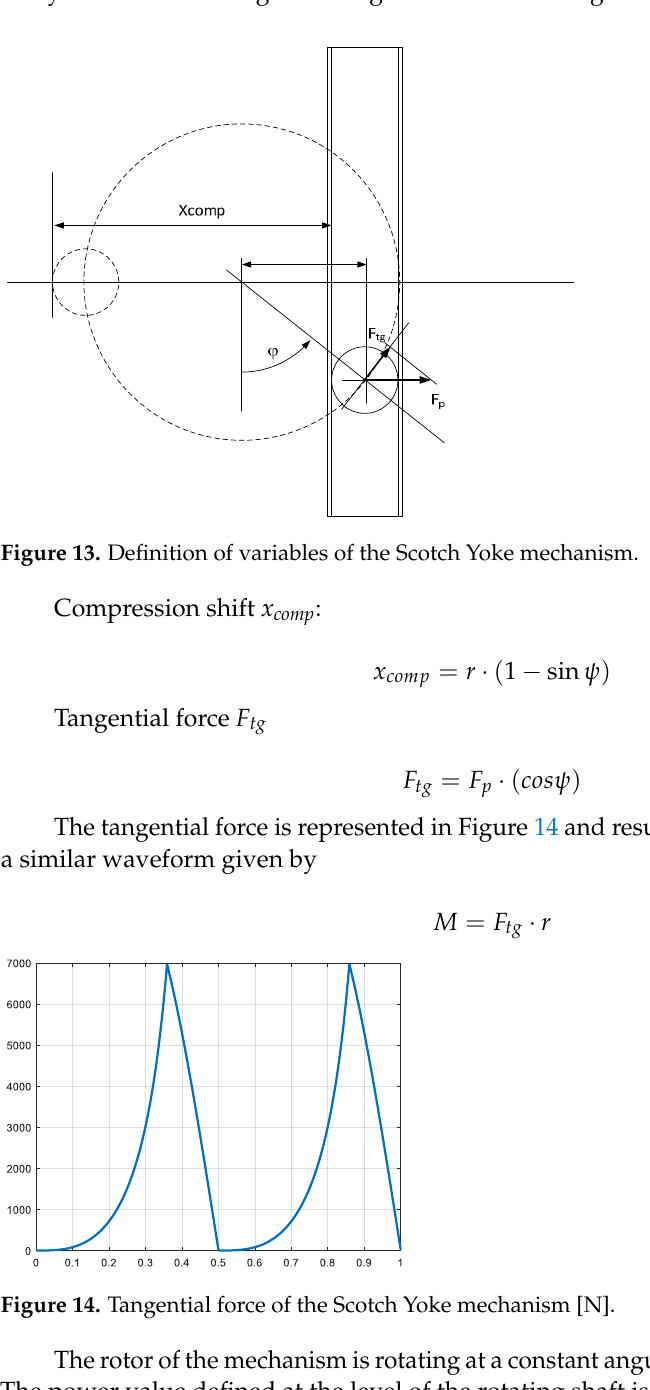
Figure 15. Load torque transmitted to the rotor [Nm].